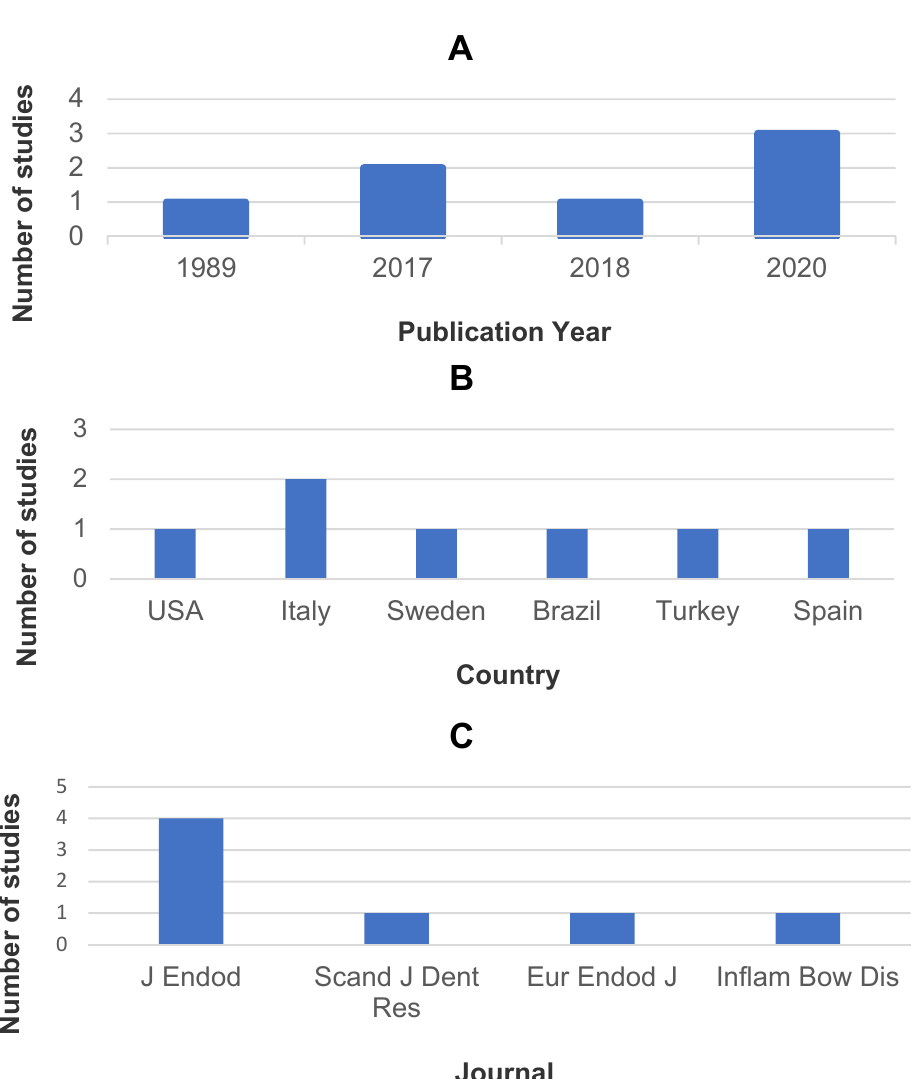
Figure 2. Bibliometric analysis: distribution of included studies by year of publication ( A ), country ( B ), and journal ( C ).